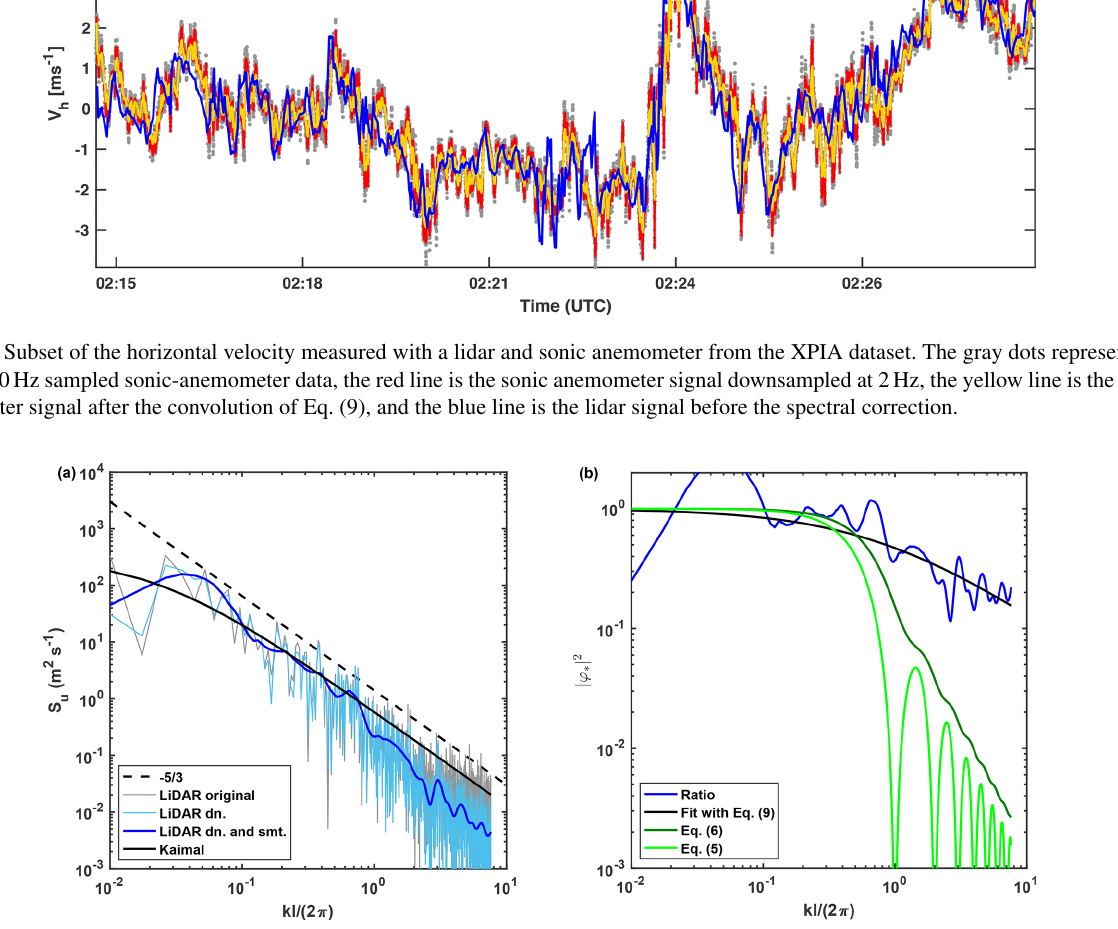
Figure 4. Correction of the lidar velocity spectrum from the XPIA dataset: (a) velocity spectra of the raw lidar data (gray), lidar data after application of the denoising procedure (To et al., 2009) (light blue), lidar data after smoothing procedure (dark blue), Kaimal spectrum (black), and − 5 / 3 slope (black dashed); (b) | ϕ ∗ | 2 (blue), | ϕ ∗ | 2 fitted with Eq. (9) (black); predictions from Eq. (5) (bright green) and Eq. (6) (dark green) are reported as